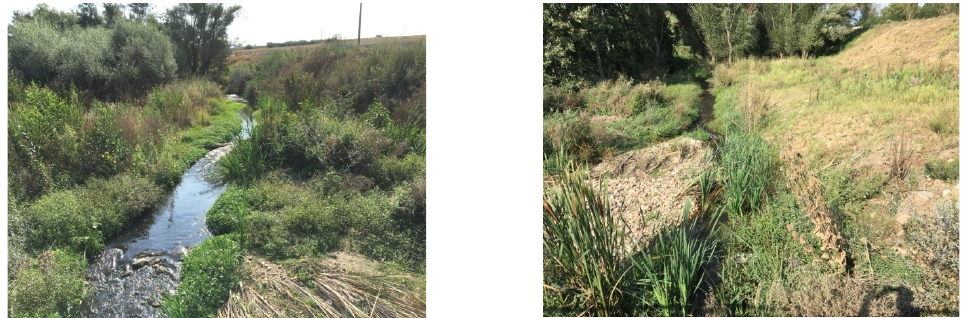
Figure 5. View of the channel riverbed downstream of Papadia dam. Table 3. Manning roughness coefficient values according to land cover.